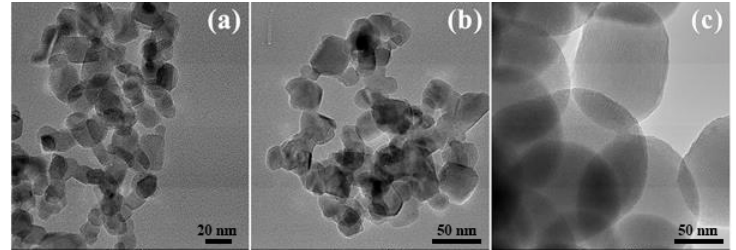
Figure 1. Low-magnification TEM bright-field images of 2.43 × 10 − 3 % Au–S–CH 2 –CH 2 –OH/TiO 2 (0.5 g/L) nanocomposites: irregular shaped ( a , b ) and spherical shaped ( c ) particles.